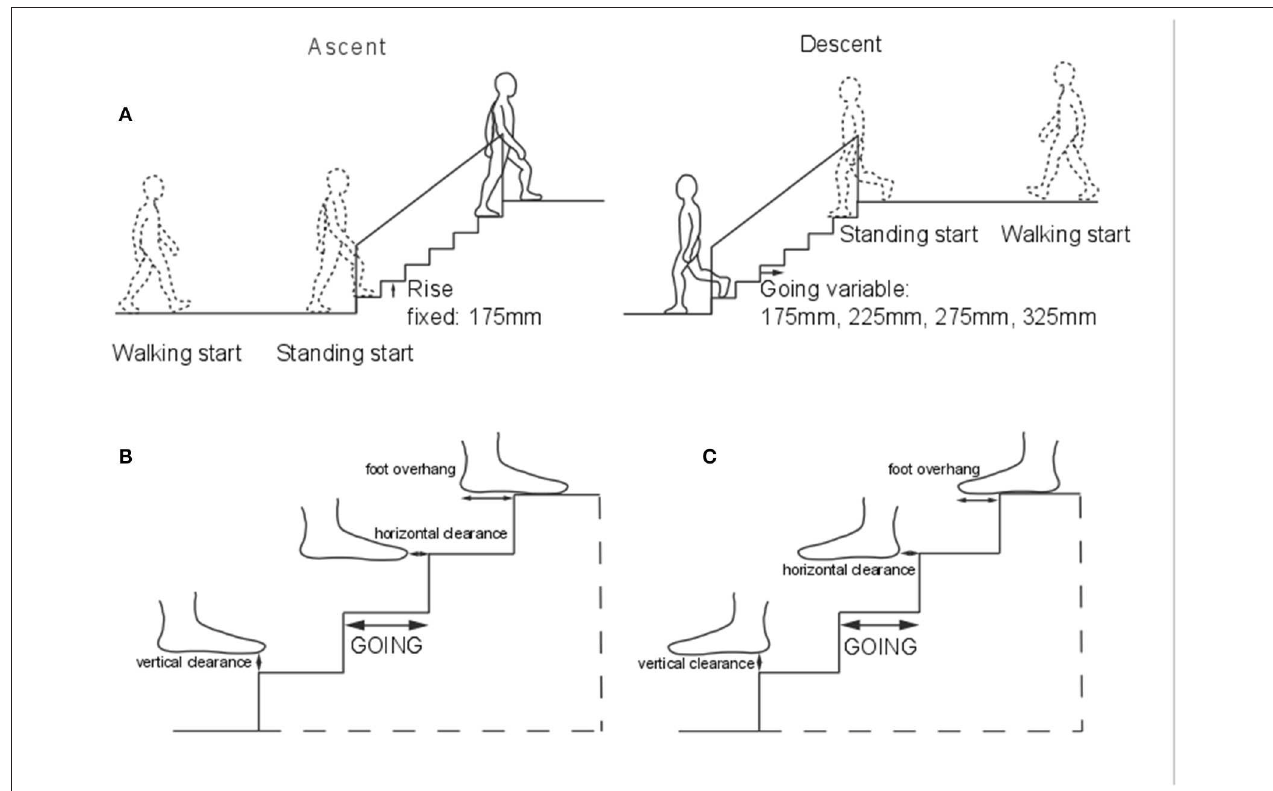
FIGURE 1 | Apparatus. (A) The seven-step instrumented stair. Step size: rise (height) 175mm, going 175, 225, 275, and 325mm. Four force platforms were embedded in steps 2–5. Handrails were provided on each side. Representation of the vertical and horizontal clearance and overhang in ascent (B) , and descent (C)